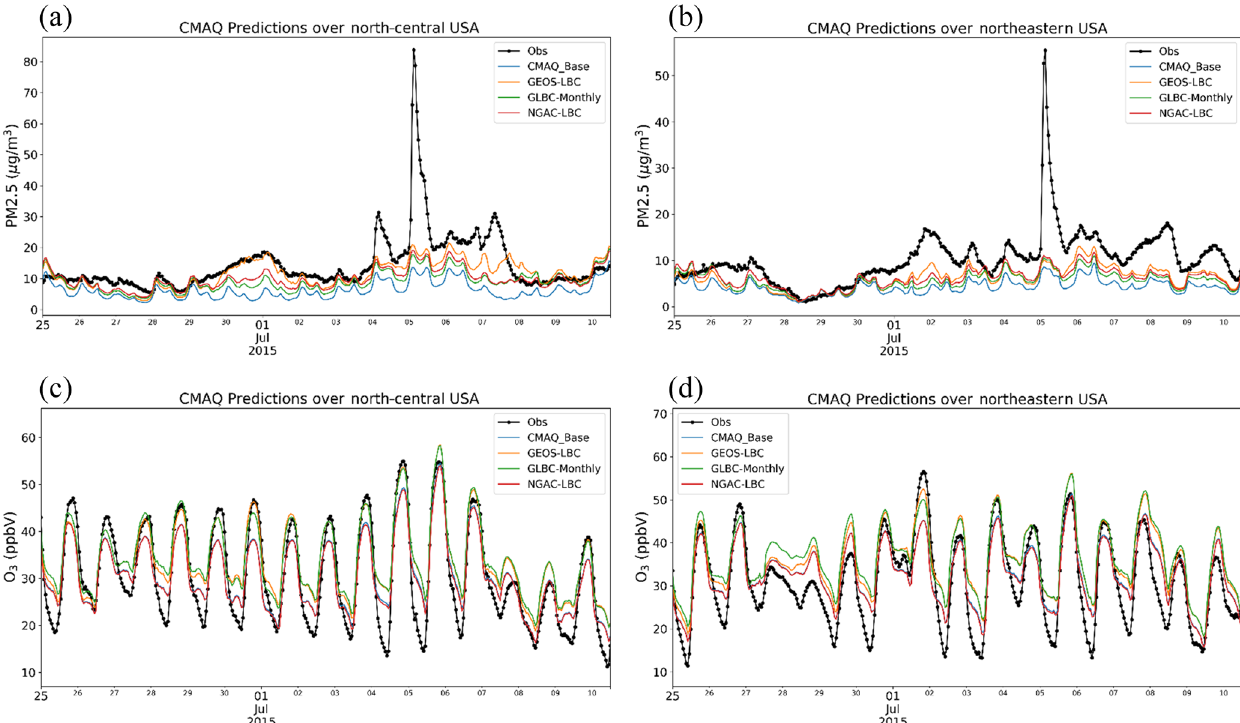
Figure 10. Time-series comparisons for PM 2 . 5 (a, b) and O 3 (c, d) over the north-central region (a, c) (states of Illinois, Indiana, Iowa, Kentucky, Michigan, Minnesota, Missouri, Ohio, and Wisconsin) and northeastern USA (b, d) (states of Connecticut, Delaware, Maine, Maryland, Massachusetts, New Hampshire, New Jersey, New York, Pennsylvania, Rhode Island and Vermont and the District of